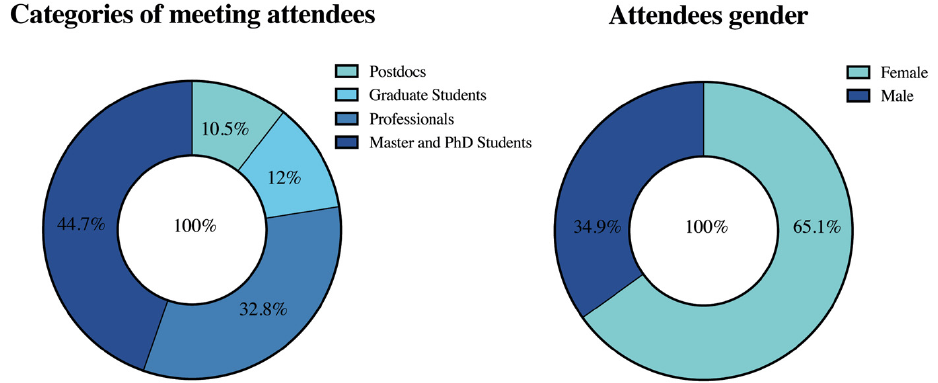
Figure 2. Percentage of attendees by categories ( left ) and by gender ( right ).